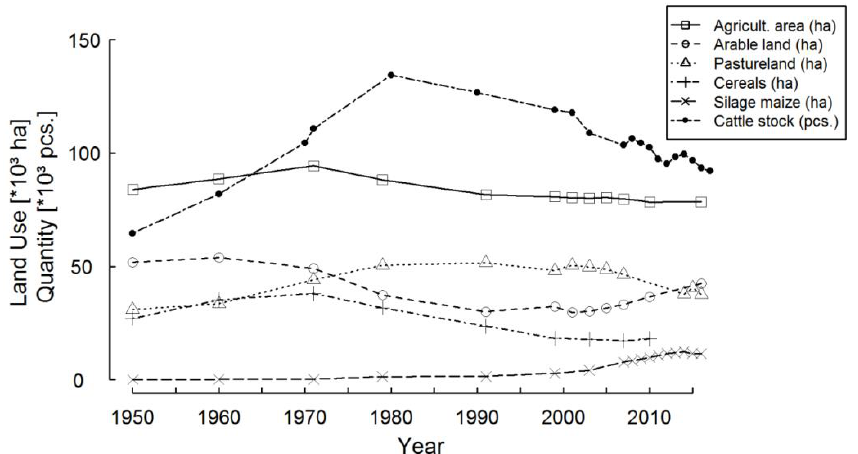
Figure 1. Development of the land-use (cereals excluding silage maize) and of the agricultural structure in the study region during the last decades based on census data [14,15].